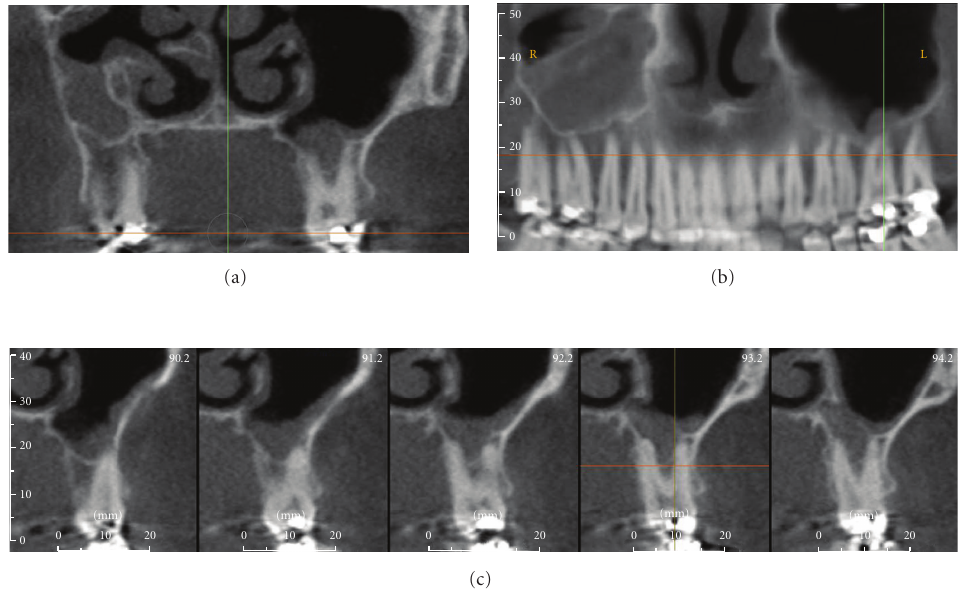
Figure 8: On conventional intraoral periapical radiography periapical mucositis (PM) presents as a relatively radiopaque, soft-tissue, dome-shaped lesion localized to the apex of a maxillary posterior tooth and projecting into the floor of the maxillary sinus. Most are indistinguishable from mucosal lesions of intrinsic sinus origin such as antral mucosal pseudocysts (see Figure 9). While clinically asymptomatic, they are usually associated with necrotic or failing root canal-filled teeth. PM is a localized mucosal thickening of the sinus membrane, secondary to a breach of periradicular inflammation, and will resolve after successful endodontic treatment. This patient gave a history of persistent left side pain over the maxillary molar region of 4-month duration. Treatment for sinusitis did not relieve the symptoms. Panoramic and intraoral dental radiology did not reveal a cause. Coronal CBCT imaging (a) demonstrates acute sinusitis bilaterally with 50% to 70% opacification and previous uncinectomy and antrostomy (as evidenced by the loss of the superior medial wall of the right sinus) of the right sinus, whereas the left sinus shows thickened mucosal lining with a dome-shaped soft tissue lesion overlying the roots of the restored left maxillary first molar tooth. 5mm reformatted panoramic (b) and 1 mm cross-sectional (c) reconstructions of the maxillary left first molar show periapical lesional penetration and communication with the floor of the sinus in this region. Data acquired on an iCAT, Imaging Sciences International, Hatfield, PA USA at 0.3 mm resolution and reformatted using InVivo Dental, Anatomage, San Jose, CA.